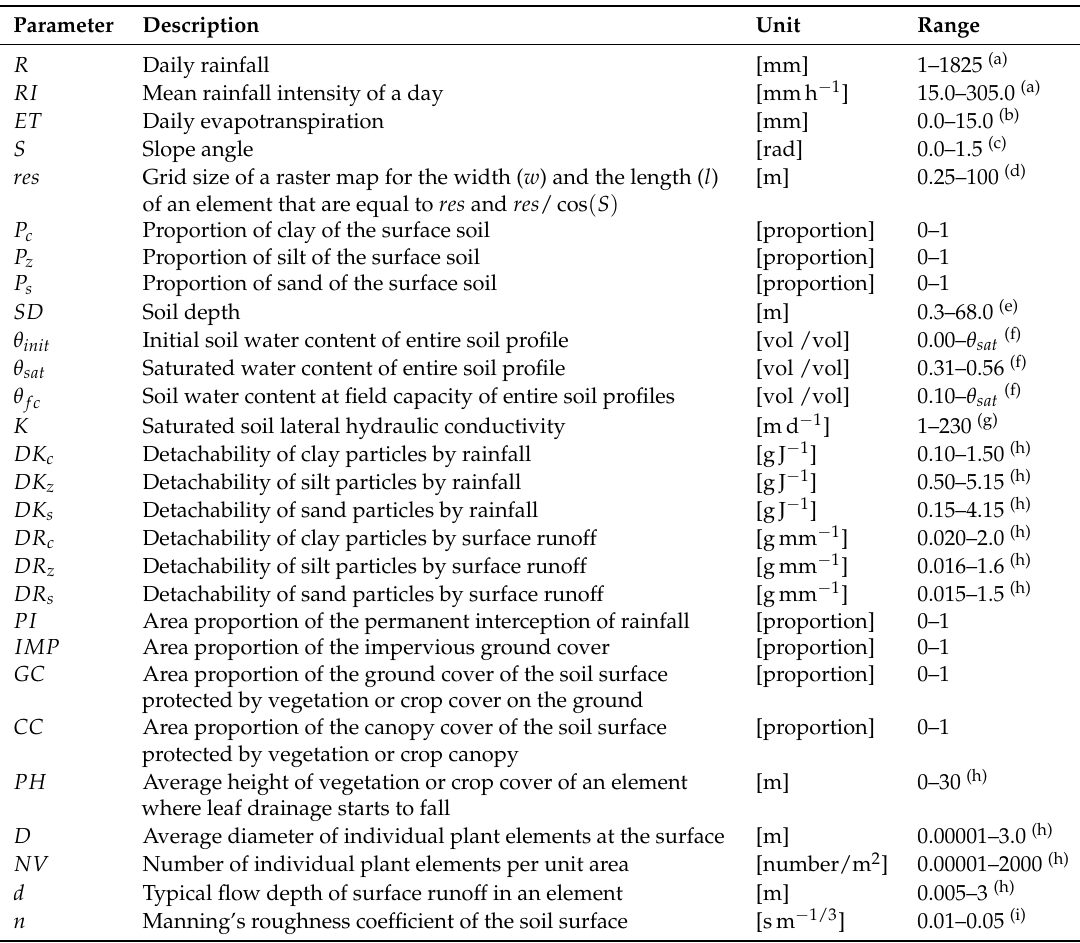
Table 1. Input parameters and their range for sensitivity